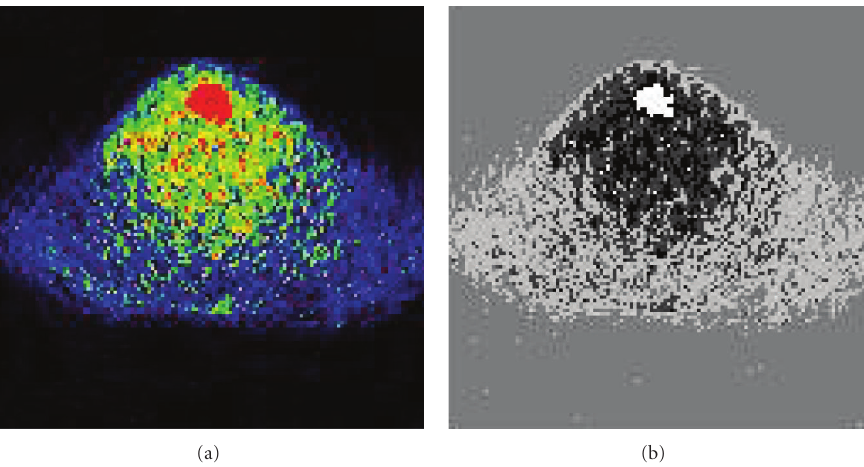
Figure 10: Clinical PET data set 2 (patient 1): (a) original PET (128 × 128) and (b) classified slice (128 ×